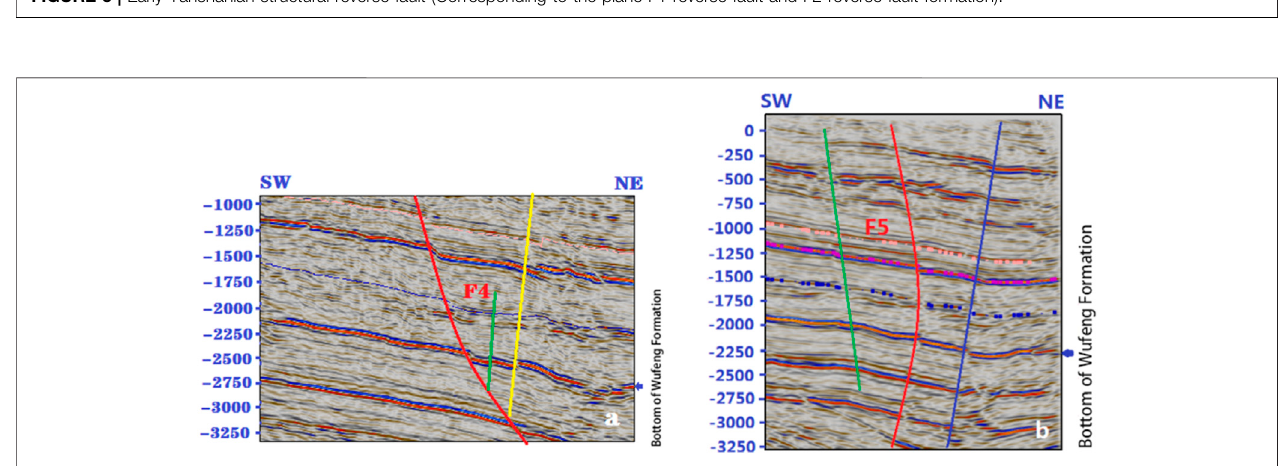
FIGURE 6 | Fault pro fi le characteristics in late Yanshanian [ (A) Midwestern herringbone fault; (B) Left-hand strike-slip structure in central-eastern].